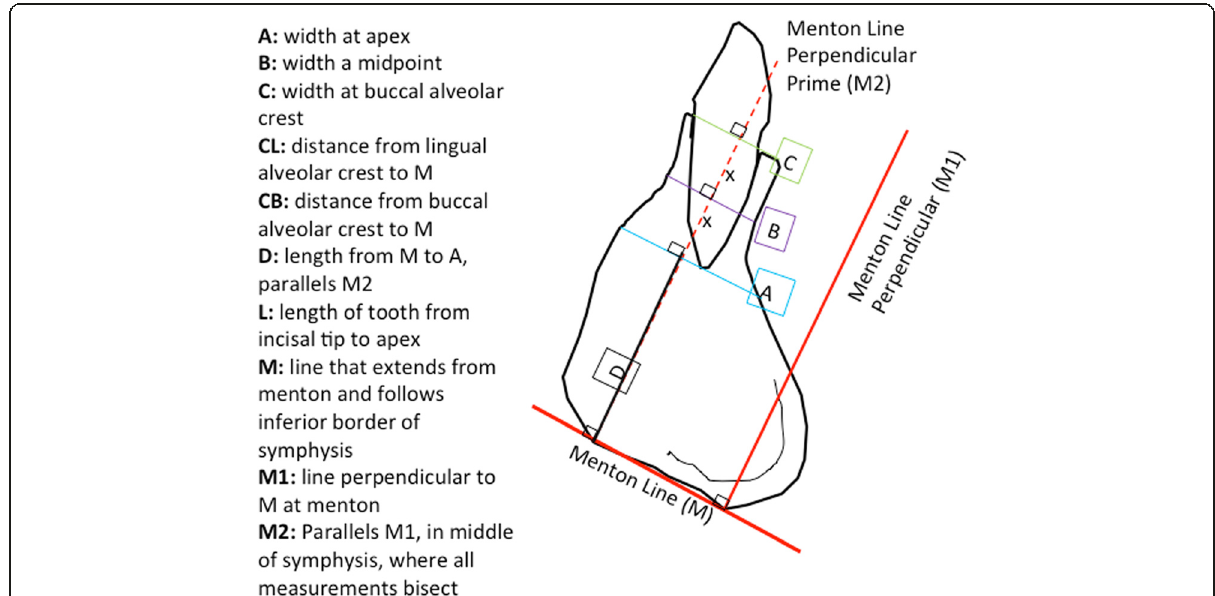
Fig. 3 Schematic of measurements determined from a sagittal view of the tooth outlining the width and distances to determine changes in the tooth and alveolar bone